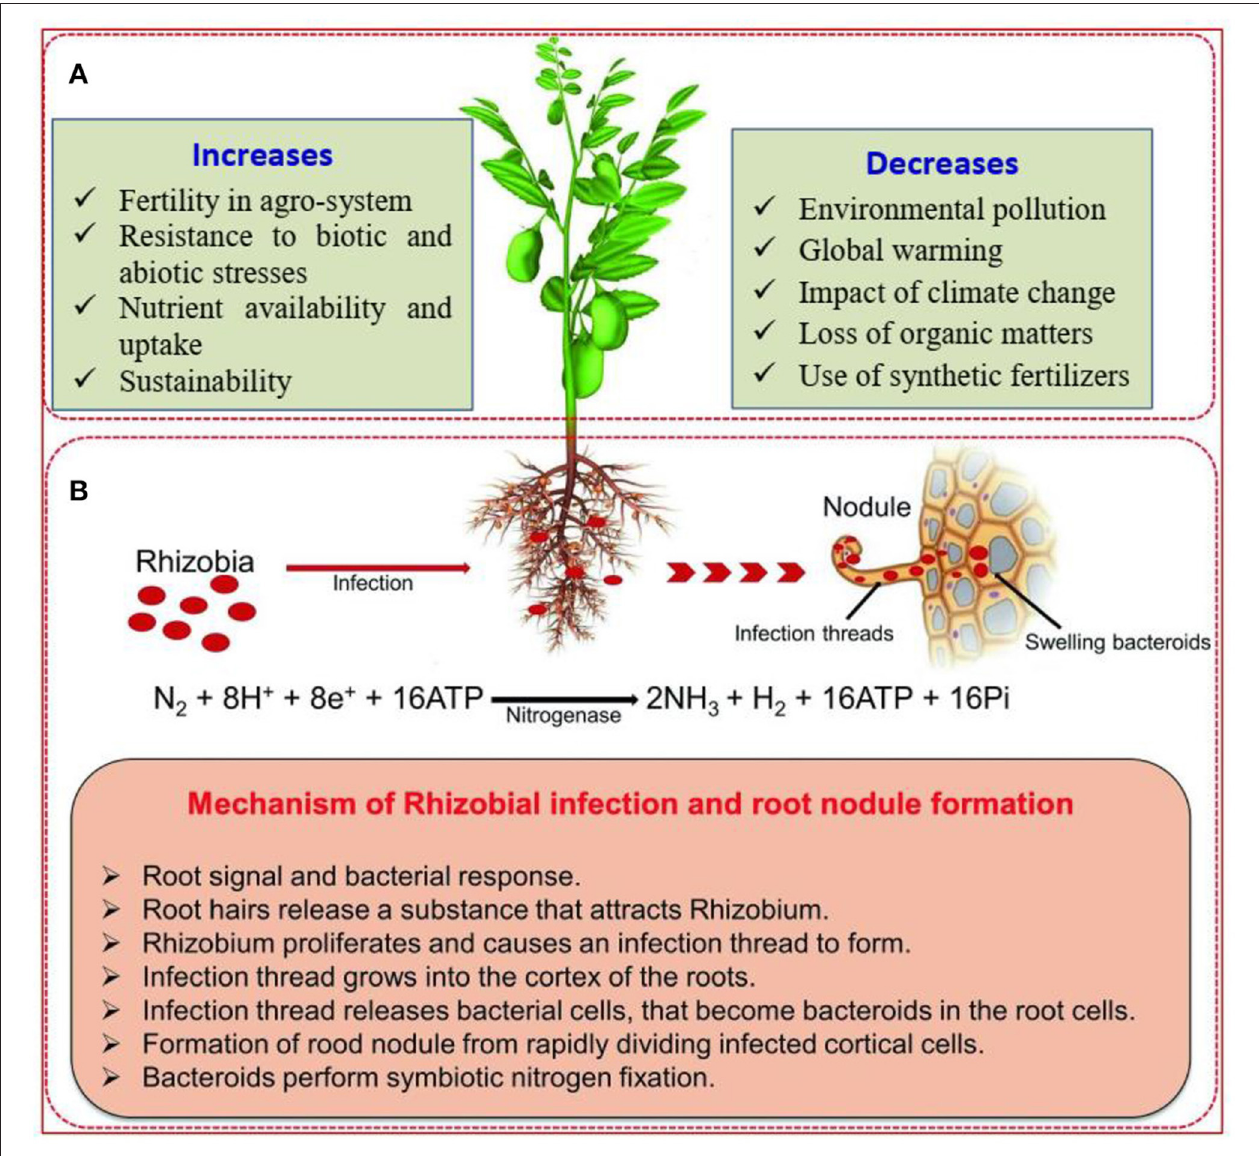
FIGURE 1 | (A) Overview of the benefits of biological nitrogen fixation by legumes in agricultural production. (B) Diagrammatic scheme showing the application of rhizobia and mechanisms of symbiotic nitrogen fixation in legumes. Source: Raza et al. (2020).